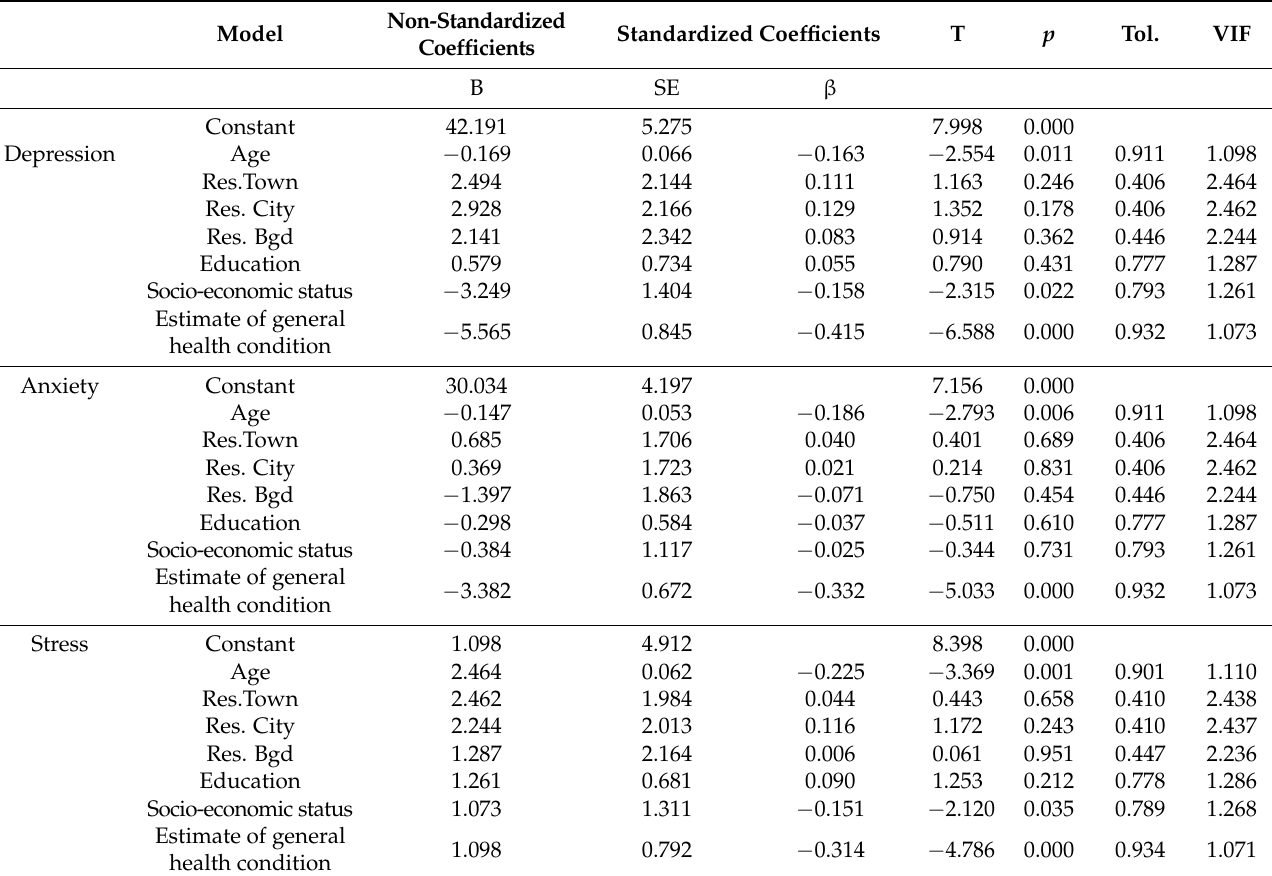
Table 7. Regression coefficients of Depression, Anxiety, and